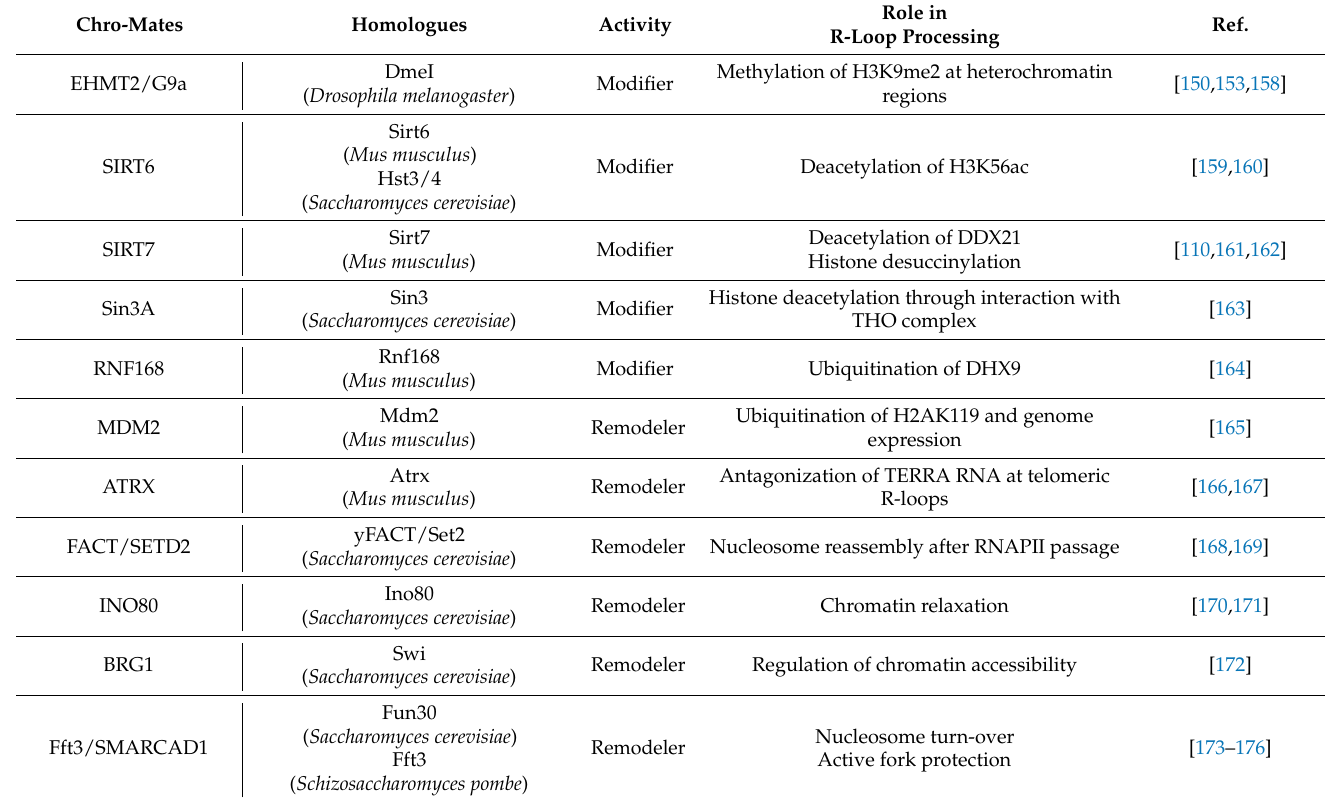
Table 1. Representative Chro-Mates implicated in the processing of